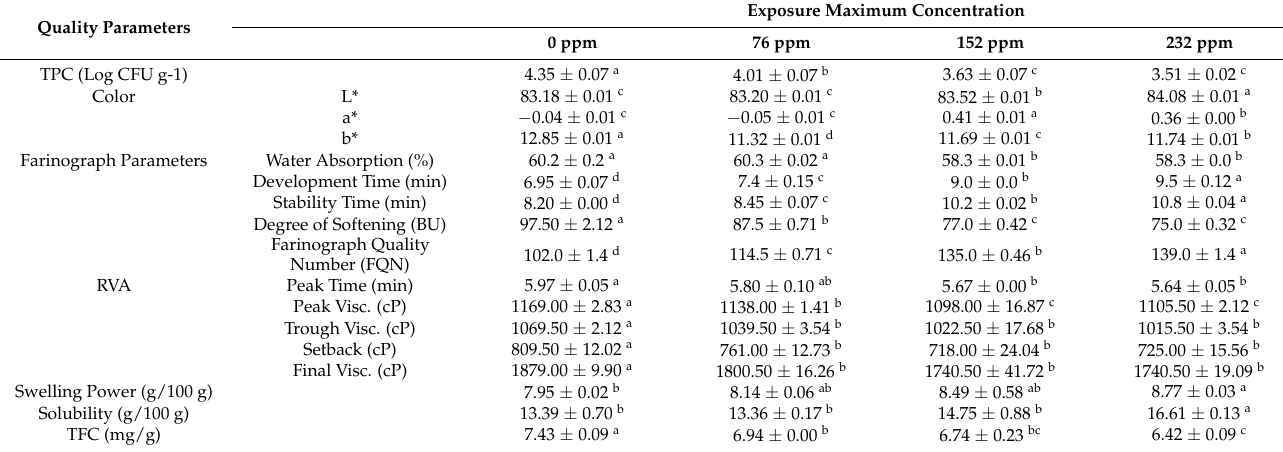
Table 1. TPC and physiochemical of buckwheat-based composite flour as affected by chlorine dioxide treatment. Quality